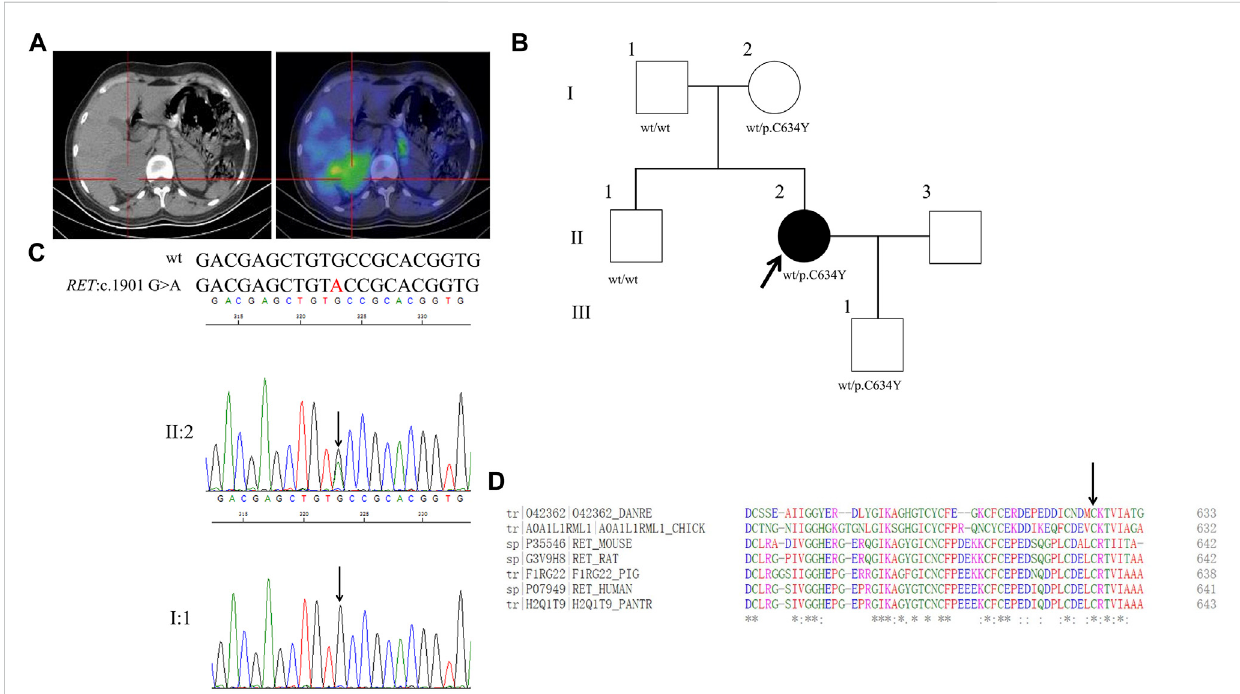
FIGURE 6 Clinical and genetic characteristics of Proband 6. (A) 131I-MIBG SPECT/CT imaging in a 27-year-old female patient with PPGL showing a right adrenaloccupancy.CT(left)andSPECT/CT(right)transaxialsectionsareshownfortherightadrenaloccupancy. (B) PedigreeoftheProband6familywith PPGL. Squaresandcircles indicatemales andfemales,respectively;Roman numerals indicate generations; andArabicnumeralsindicate individualfamily members.Eachmember ’ s RET genotypeisshownbelowthesquaresandcircles.Wt,wildtype.C,cystein.Y,tyrosine. (C) DNAsequencingdataofan unaffected male (I:1) and the Proband 6 (II:2) with the heterozygous variant of RET :c.1901 G > A. wt, wild type. (D) Multiple protein sequence alignment of seven species for RET p.C634 (arrow). An asterisk (*) indicates positions that are 100% conserved in the alignment, and a colon (:) indicates conservation between groups of strongly similar properties, whilst a period (.) indicates conservation between groups of weakly similar properties. The residues in the alignment are coloured to indicate their physicochemical properties. Red indicates small and hydrophobic amino acids, blue indicates acidic residues, magenta indicates basic and green denotes hydroxyl/sulfhydryl/amine